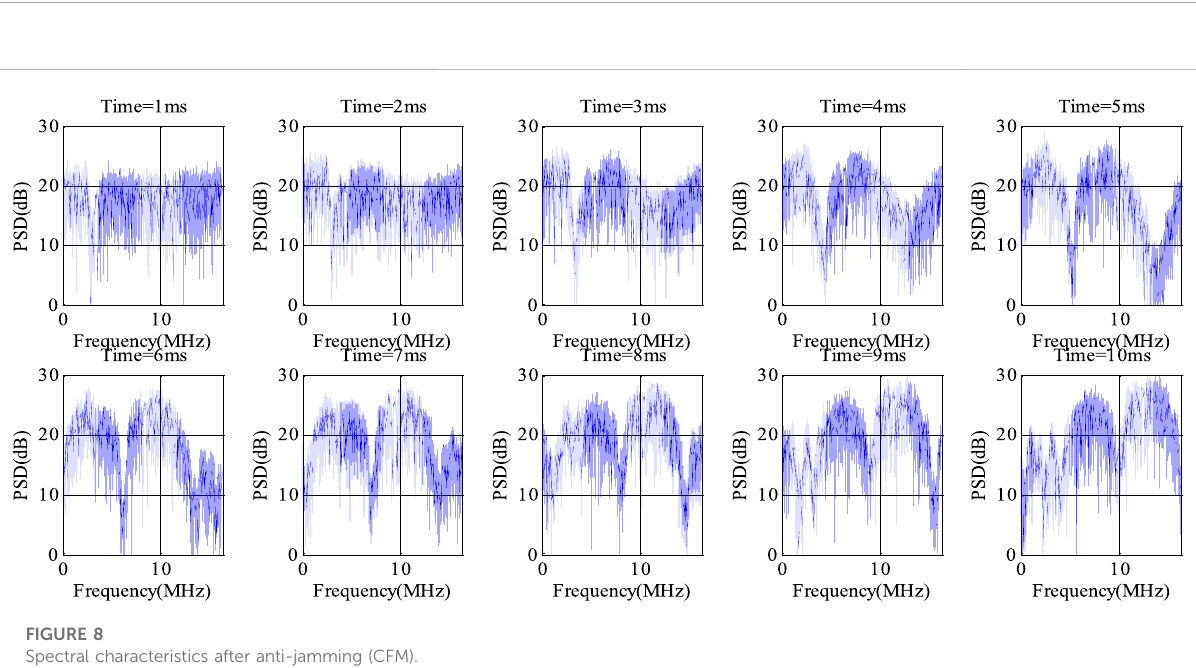
FIGURE 8 Spectral characteristics after anti-jamming